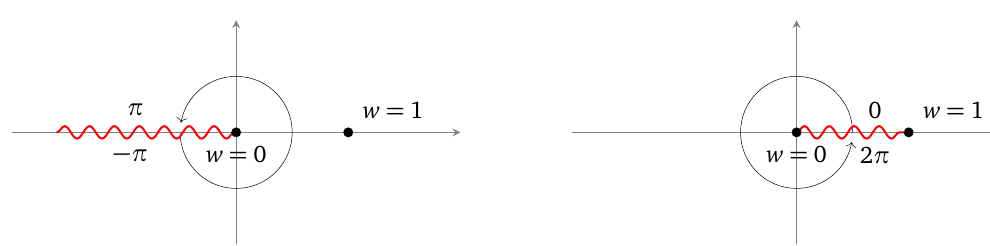
Figure 12: Branch cuts of the geometric periods